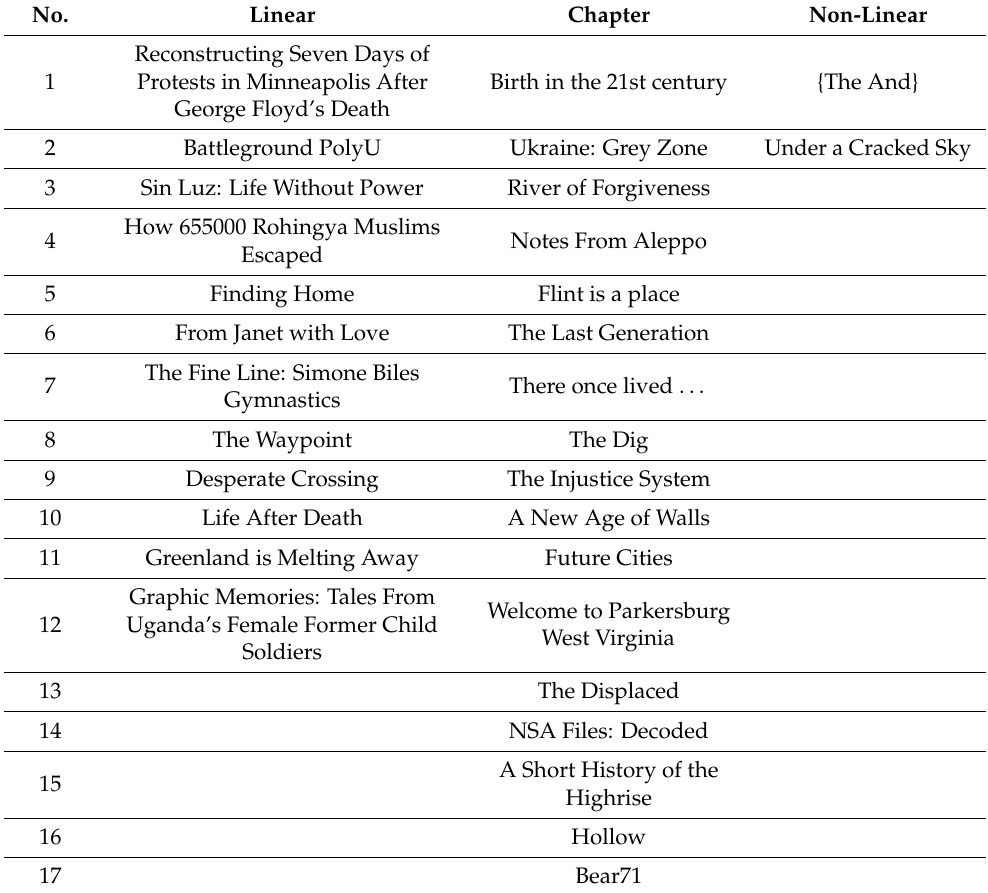
Table 4. Overview of long forms by type of